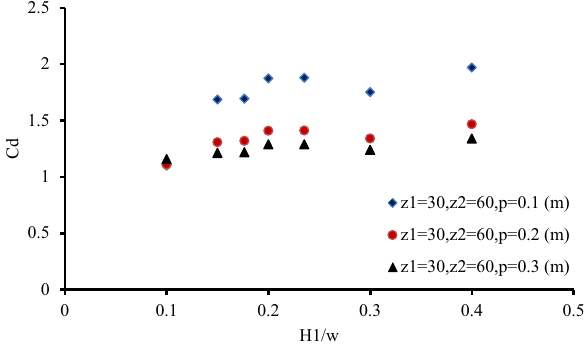
Fig. 9 Discharge coefficients for z upstream slopes